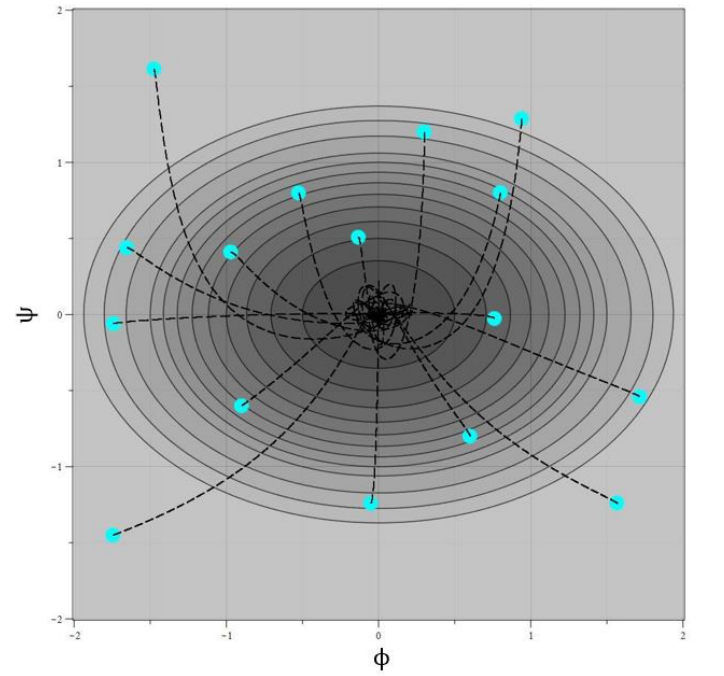
Figure 1. Isolines of the interaction potential (45) with phase trajectories for a set of 16 starting